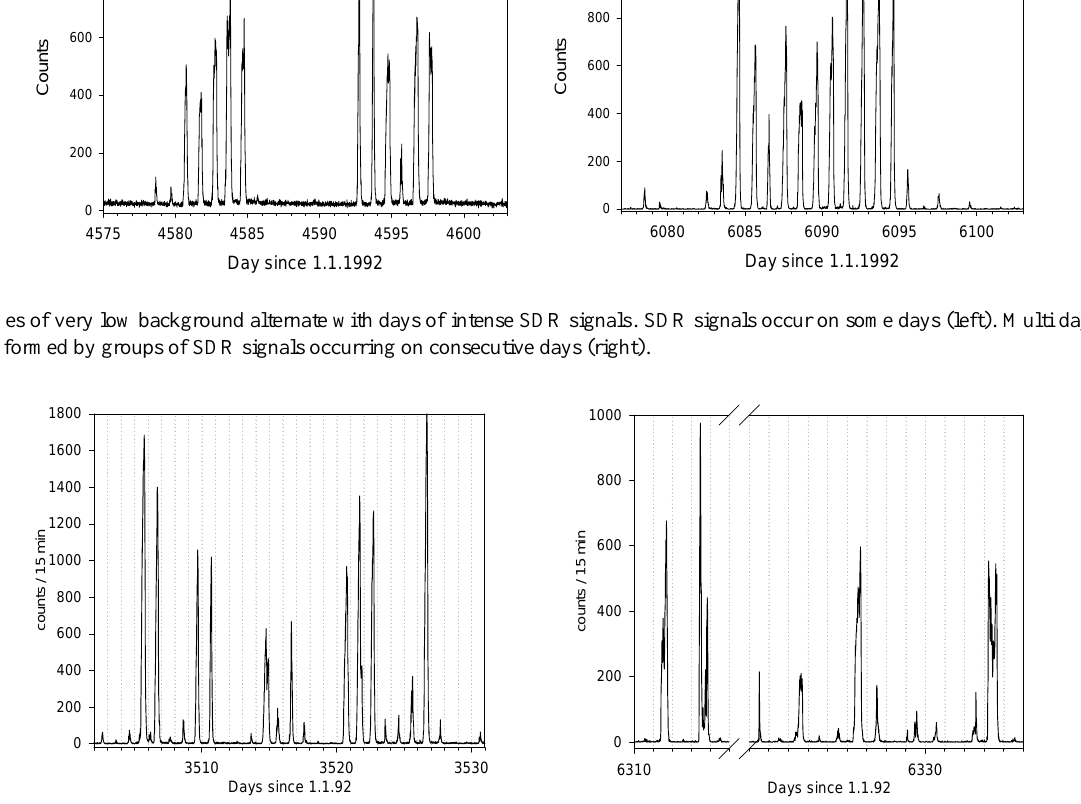
Fig. 7. Time intervals showing isolated and grouped SDR signals with intervening days without any signal (left). In some cases two peaks Figure 7: Time intervals showing isolated and grouped SDR signals with occur within a day intervening days without any signal (Left). In some cases two peaks occur within a day (Right).